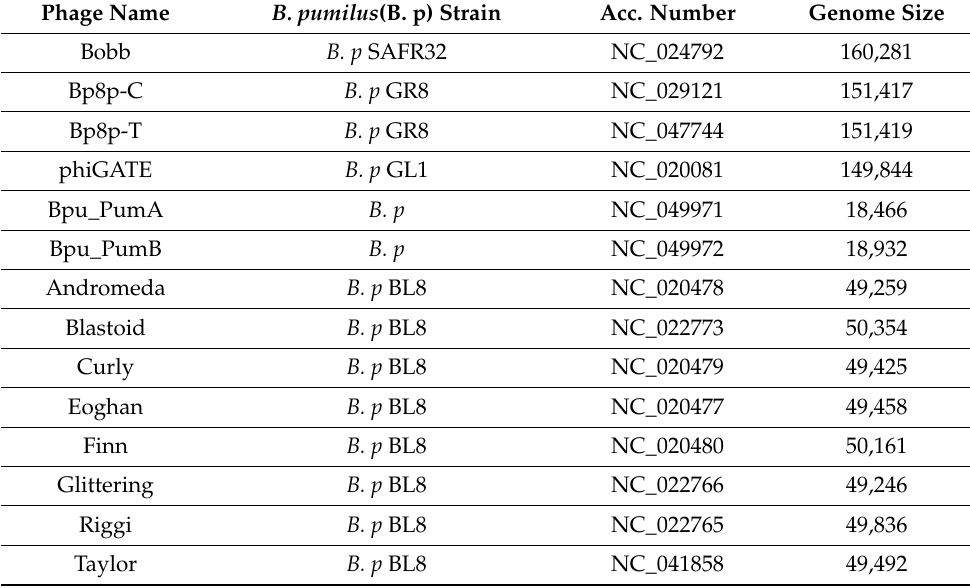
Table 6. B. pumilus phages found in viral genome database at NCBI *. The name of the phage, the strain used for multiplication, the access number and genome size are